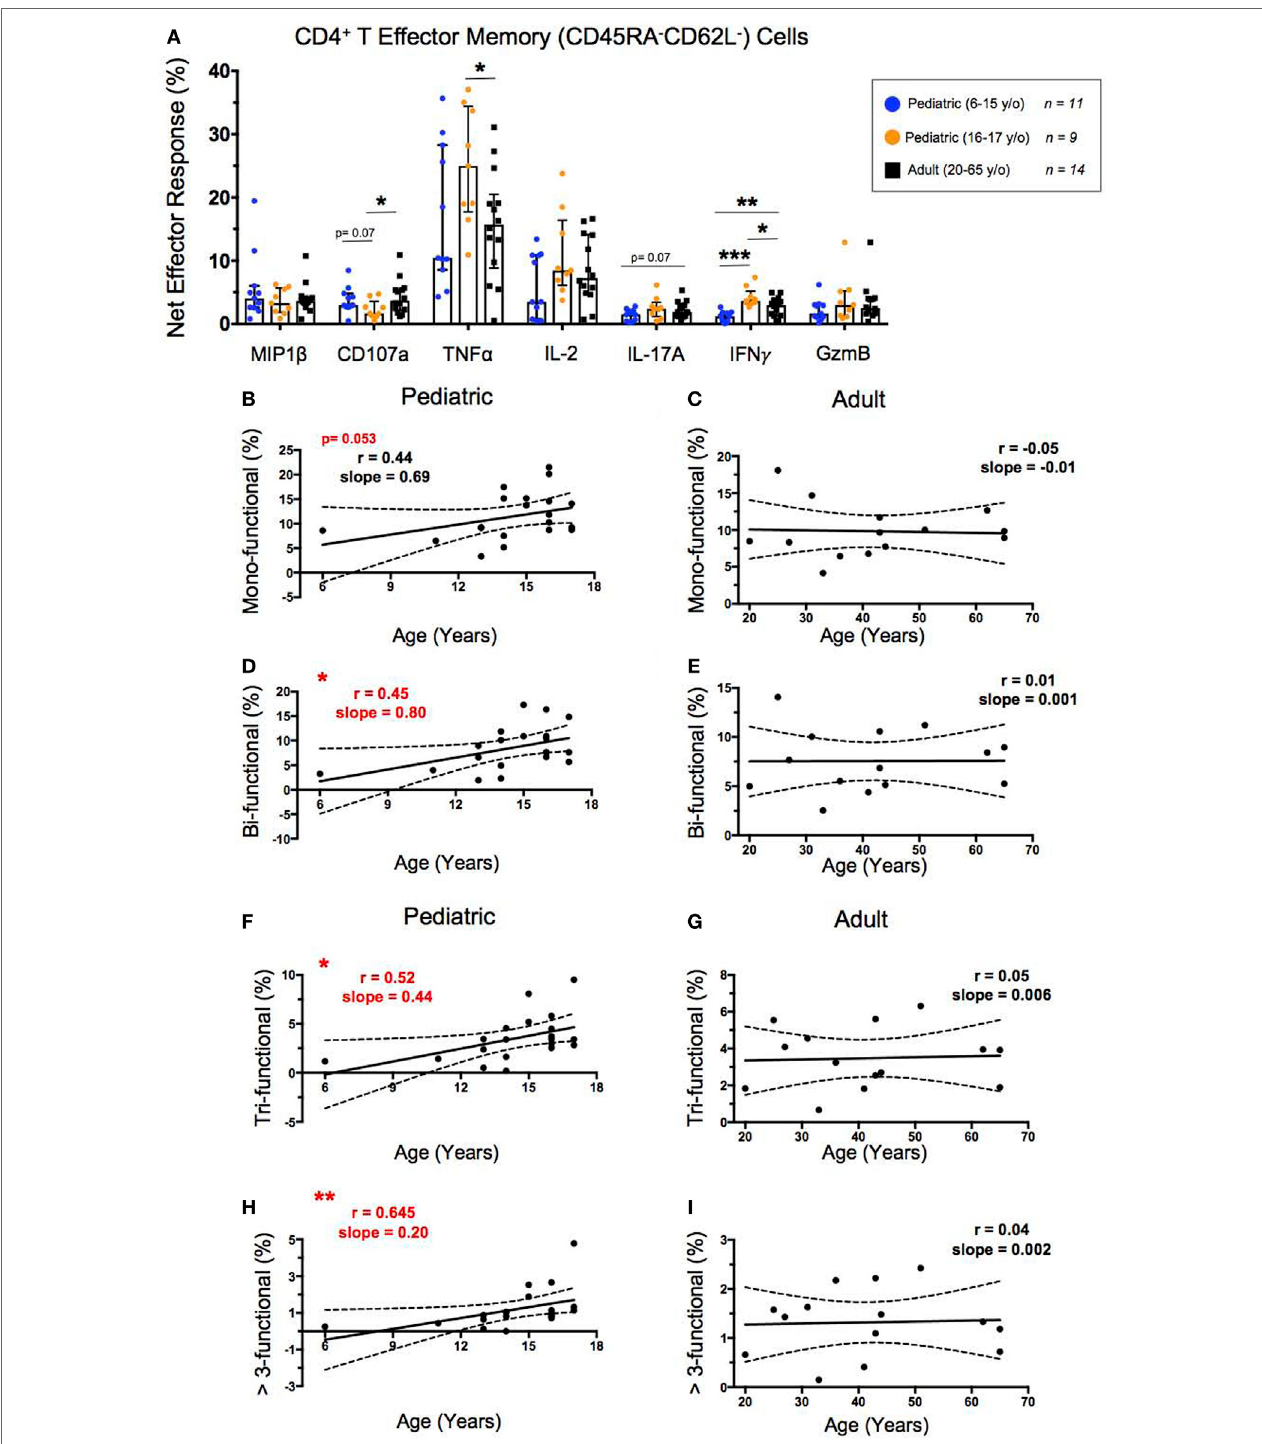
FigUre 3 | CD4 + T effector memory response. (a) Scatter plot showing the net percentages of CD4 + T EM producing MIP-1 β , CD107a, TNF- α , IL-2, IL-17A, IFN- γ , and ***Granzyme B (GzmB) following SEB stimulation. Results are shown for the following populations: 6–15-year-old pediatric ( n = 11), 16–17-year-old pediatric ( n = 9), and adult ( n = 14) participants. Bars represent medians with whiskers indicating interquartile ranges. Scatter plot statistics were analyzed by unpaired t -test (* p < 0.05; ** p < 0.01; *** p < 0.001). Line graphs represent linear regression with 95% confidence intervals among CD4 + T effector memory cell mono- (B,c) , bi- ( D,e) , tri- (F,g) , and > 3- (h,i) functional populations following SEB stimulation within participants between the ages of 6–17 ( n = 20) and 20–65 ( n = 14) years old. Line graph statistics were analyzed by Spearman r correlation (* p < 0.05; ** p <